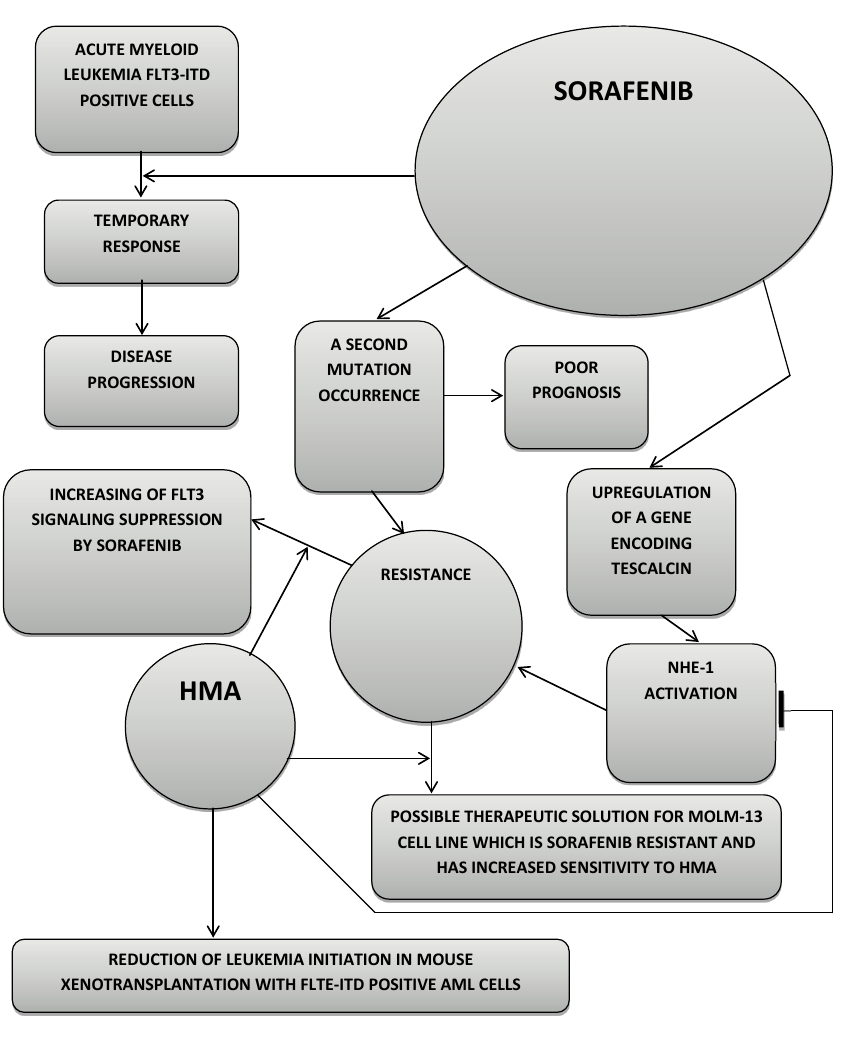
Fig. 1. The mechanisms of resistance to sorafenib. FLT3-ITD = fms-like tyrosine kinase 3; HMA = 5-(N, N-hexamethylene)-amiloride; NHE-1= Na + /H +